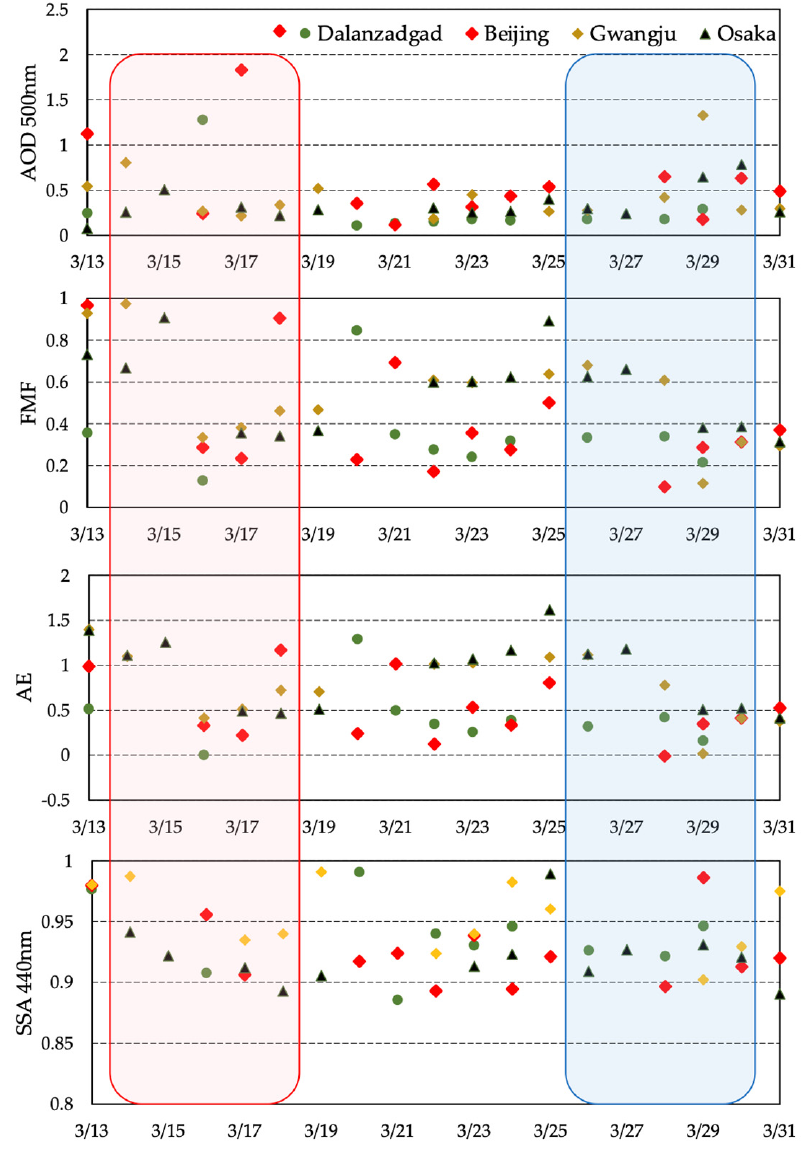
Figure 2. Time series of aerosol optical properties at four AERONET sites from 13 March to 31 March 2021. Optical parameters from top to bottom: 500 nm AOD; FMF; AE; and SSA 440 nm. On 13 March (before Beijing was impacted by dust), the AOD, FMF, and AE values at the Beijing site were approximately 1.09, 0.95, and 0.99, respectively, which indicated that fine-mode particles were predominant. This was also confirmed by the volume size distribution in Figure 3b. On 17 March, the AOD value increased to 1.82, the FMF value was only 0.24, and the AE value was 0.22, indicating that dust coarse-mode particles were predominant. From 14 to 15 March, the dust in Beijing was accompanied by the cloud layer, and the AERONET data were unavailable. During the 3 · 15 dust event, maximum (minimum) values of AOD (AE) were 0.80 (0.41) and 0.51 (0.46) at the Gwangju site and Osaka site, respectively; FMF values dropped from 0.98 to 0.34 (Gwangju site) and 0.90 to 0.34 (Osaka site). Compared with the aerosol optical parameters at the Beijing site,